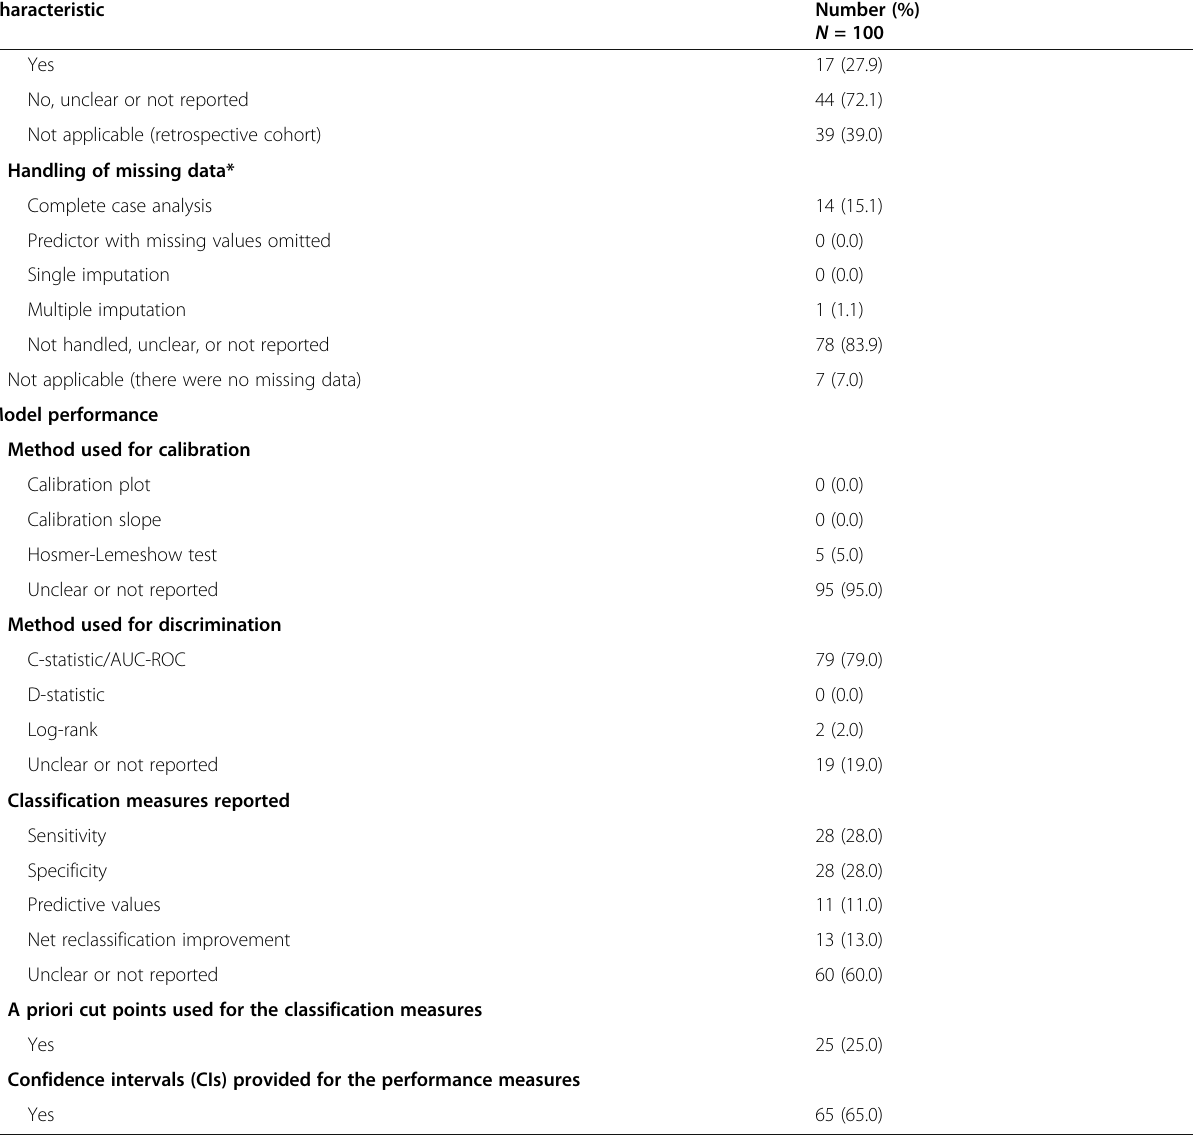
Table 2 Reporting of essential items applicable to both derivation and validation studies (Continued)